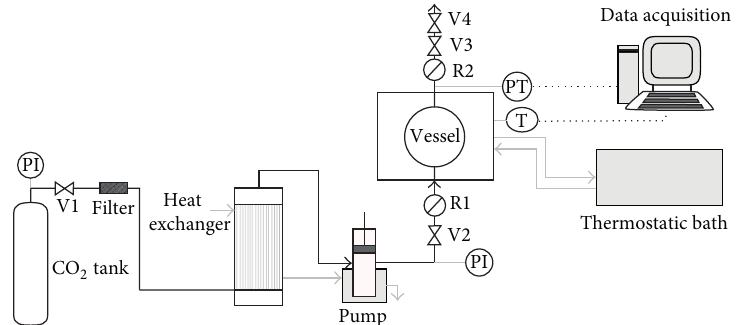
Figure 1: Schematic of the SC-CO 2 apparatus. V1 to V4: valves; R1, R2: electrical resistance; PT: pressure transducer; T: thermocouple; PI: pressure